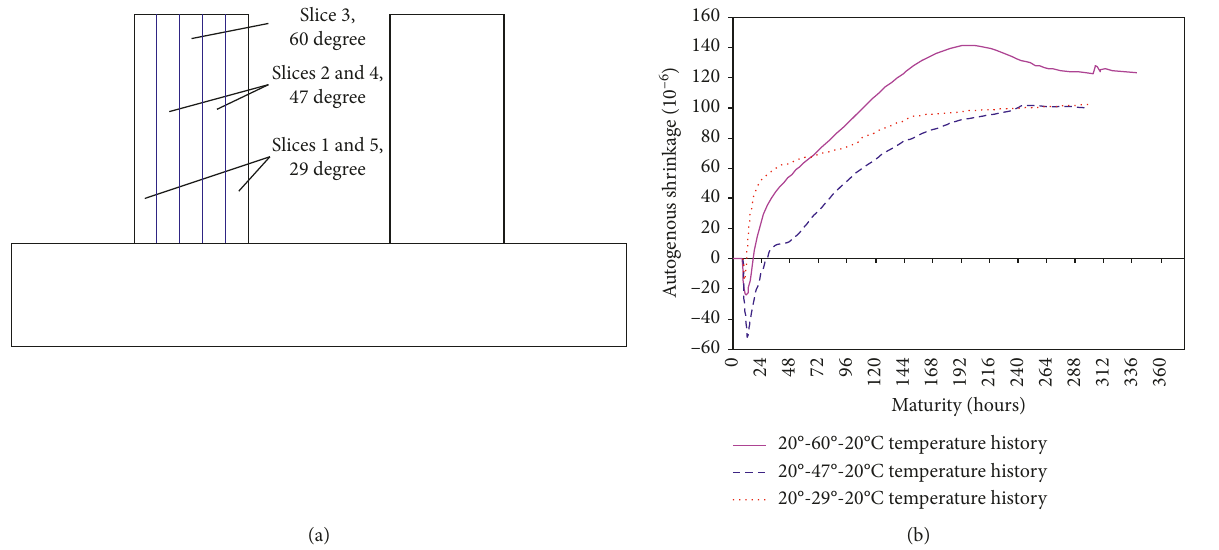
Figure 21: Different autogenous shrinkage inputs for different slices in the concrete wall.